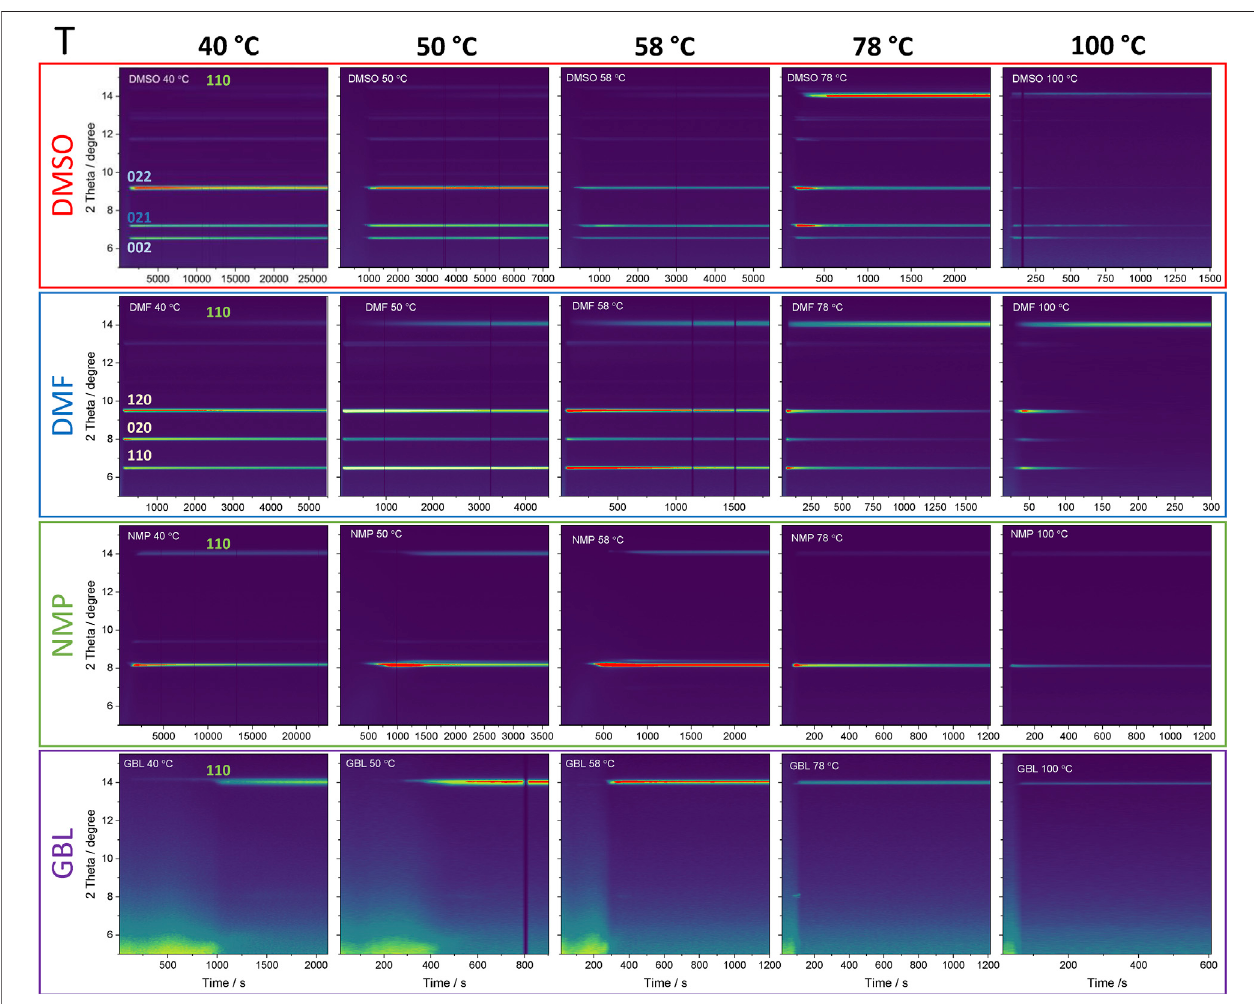
Frontiers in Energy Research |